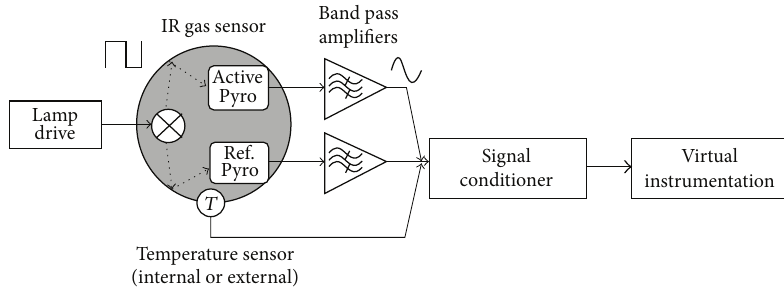
Figure 2: Blocks diagram of a typical gas detector system using an infrared